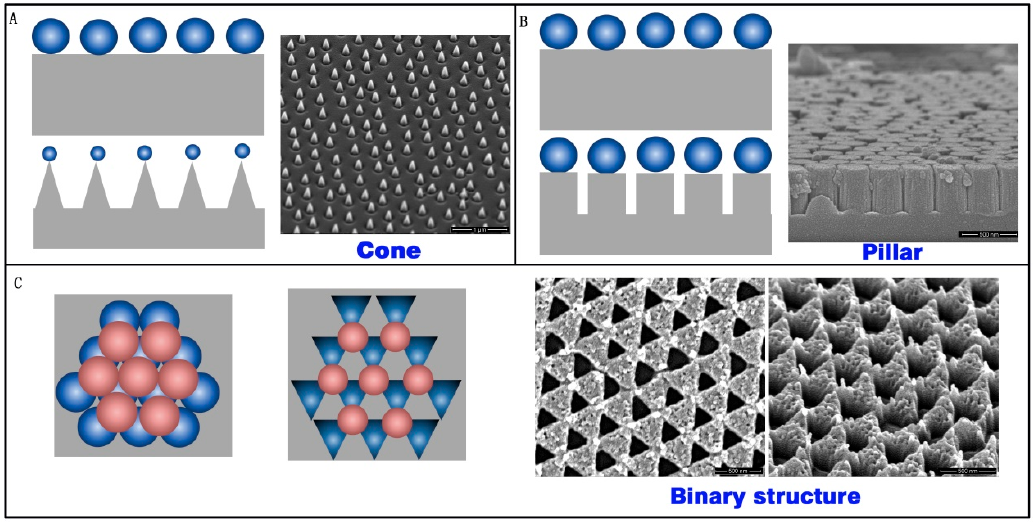
Figure 6. ( A ) Cone structure; ( B ) pillar structure; and ( C ) binary structure fabricated with reactive-ion etching (RIE) using colloidal crystals.